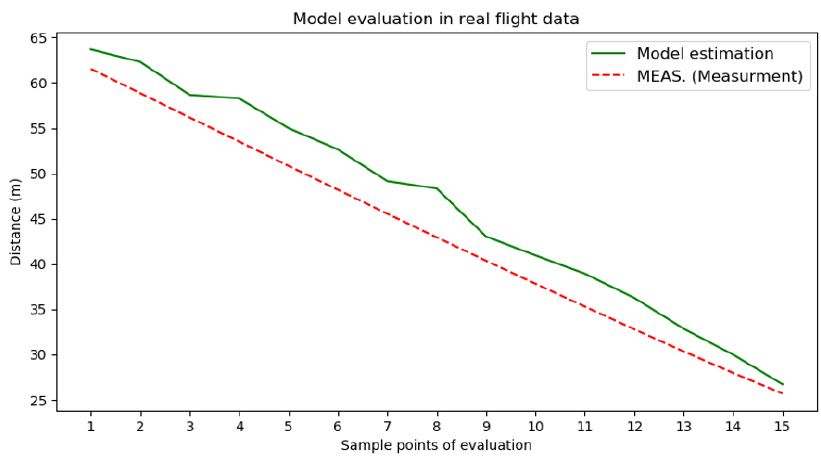
Figure 24. Measurements of GPS data for model evaluation in Experiment 2.